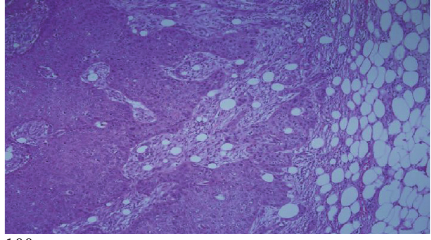
Figure 8: Left chest invasive cutaneous SCC measuring 9.8 cm, excised a few years ago, revealing desmoplastic reaction and deep invasion into subcutaneous fat, a strong predictor of metastasis [1]. Moderately differentiated.